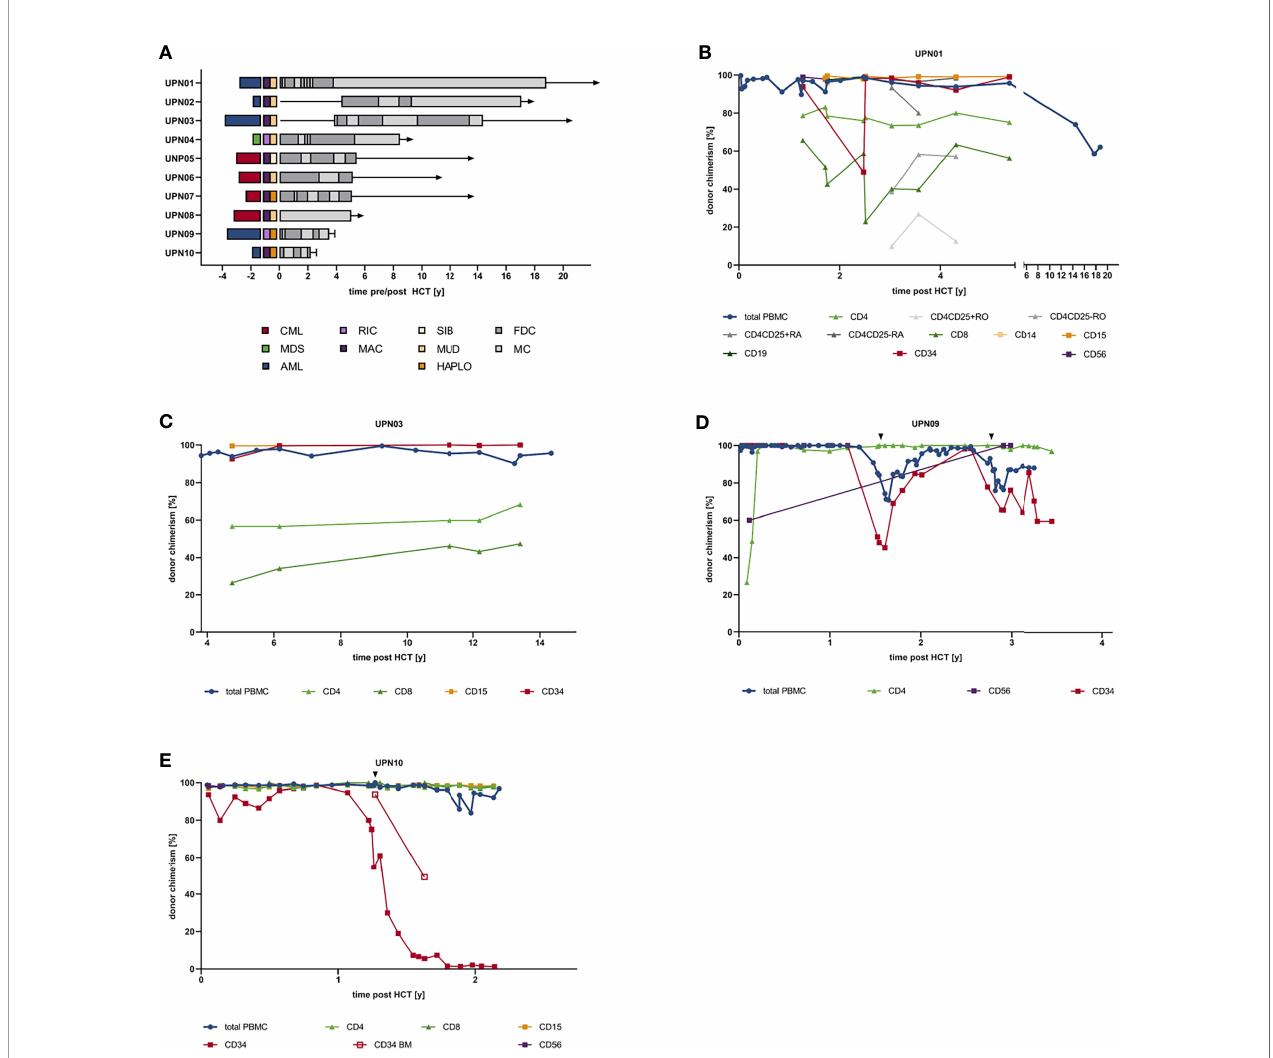
FIGURE 1 | Patient and transplant characteristics and individual donor chimerism kinetics. (A) Swimmer plot indicating diagnosis, transplant characteristics, and chimerism kinetics. (B) Chimerism kinetics of UPN01. (C) Chimerism kinetics of UPN03. (D) Chimerism kinetics of UPN09. (E) Chimerism kinetics of UPN10. AML, acute myeloid leukemia; CML, chronic myeloid leukemia; FDC, full donor chimerism; HAPLO, haploidentical donor; HCT, hematopoietic cell transplantation; MAC, myeloablative conditioning; MC, mixed chimerism; MDS, myelodysplastic syndrome; MUD, matched unrelated donor; RIC, reduced-intensity conditioning; SIB, sibling donor; UPN, unique patient